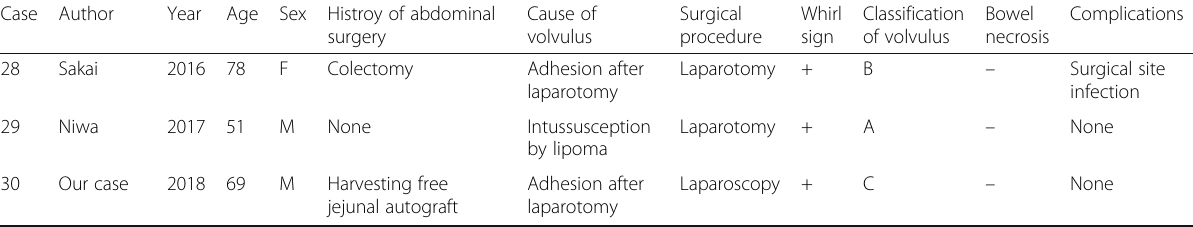
Table 1 Review of secondary small bowel volvulus cases reported in Japan (Continued)